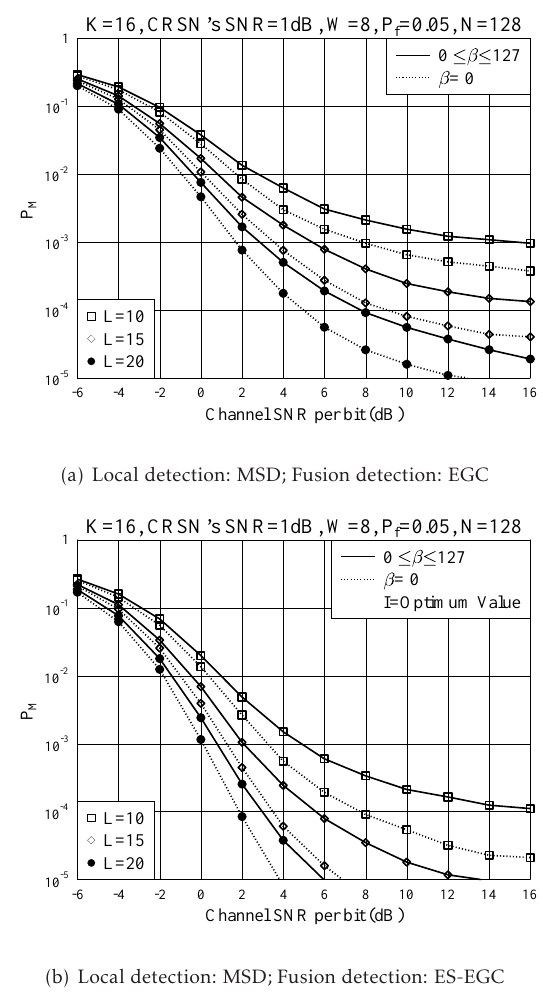
Figure 11. Overall missing probability of the cognitive spectrum sensing systems with different numbers of CRSNs, when the MSD local detection and the EGC or ES-EGC assisted fusion detection are